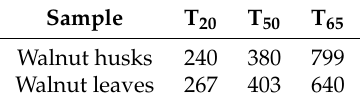
Table 1. T 20 , T 50 , and T 65 of plant materials: walnut husks and leaves.